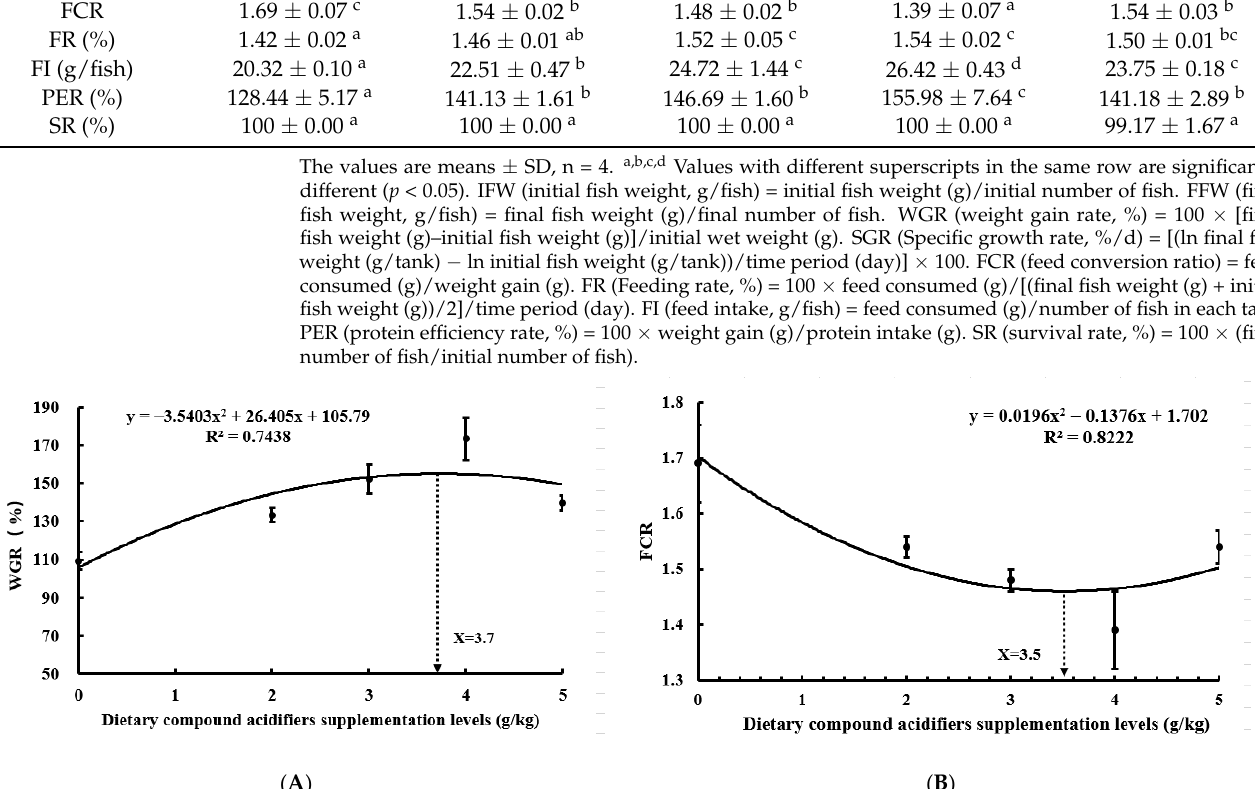
Table 1. Growth performance of juvenile American eel in different CAs supplementation groups.